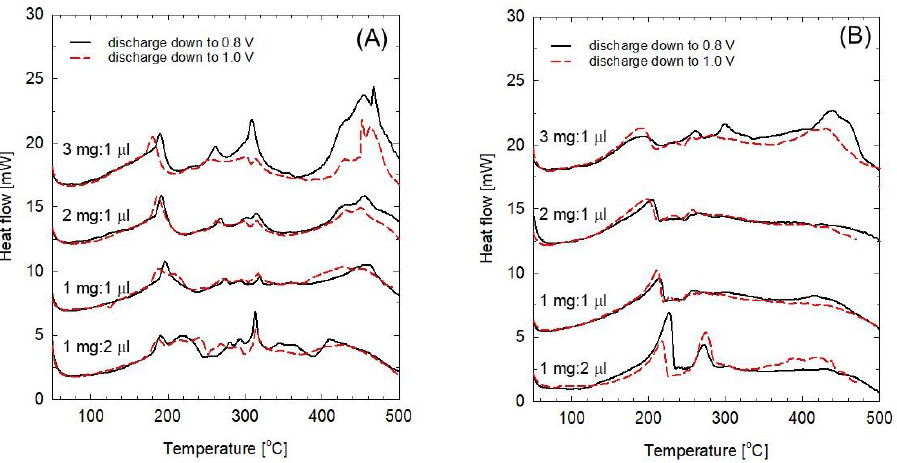
Figure 4. DSC curves of mixtures of the ( A ) sodiated and ( B ) desodiated FeOF cathode and the electrolyte at different electrode/electrolyte ratios. The curves obtained with the electrode cycled in voltage ranges of 0.8–4.0 V and 1.0–4.0 V are presented by a solid black line and broken red line, respectively.